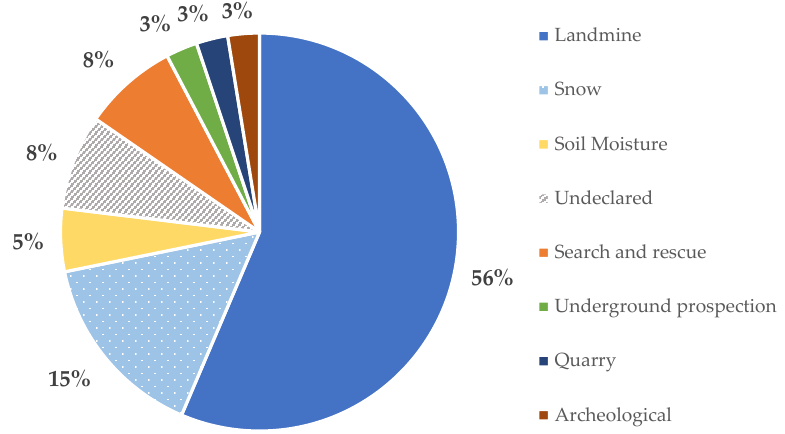
Figure 21. Percentage of papers in terms of specific application in GPR category.